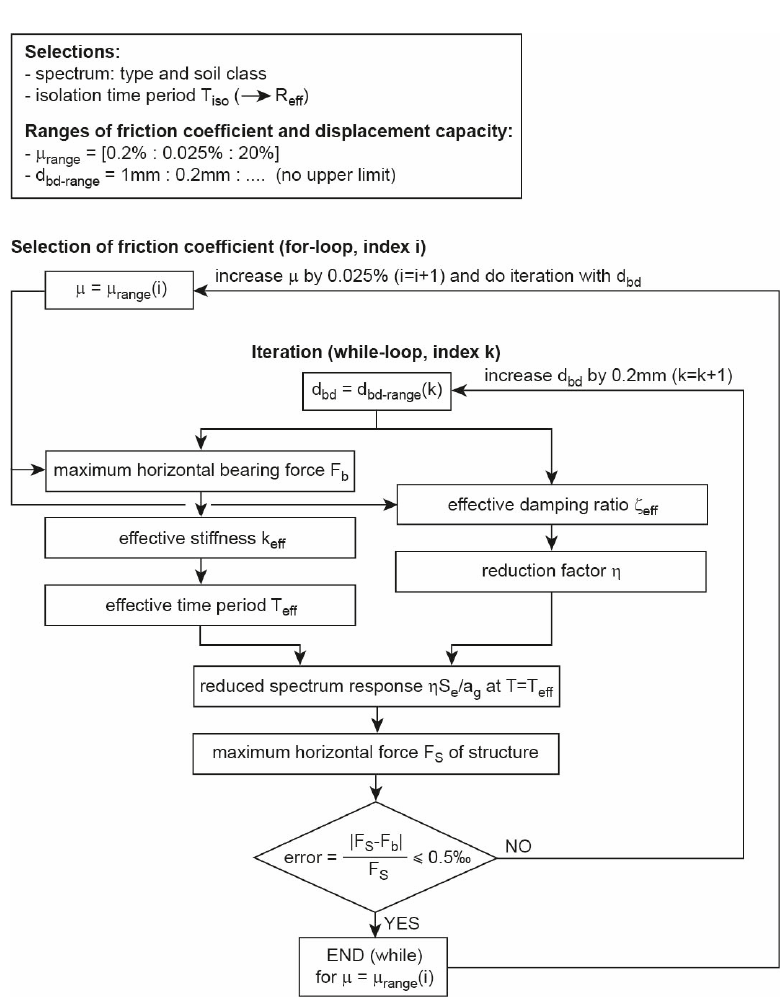
Figure 2. Flow chart of software program to compute all valid CSS designs. R eff : effective radius; µ range : range of friction coefficient; d bd-range : range of displacement capacity.